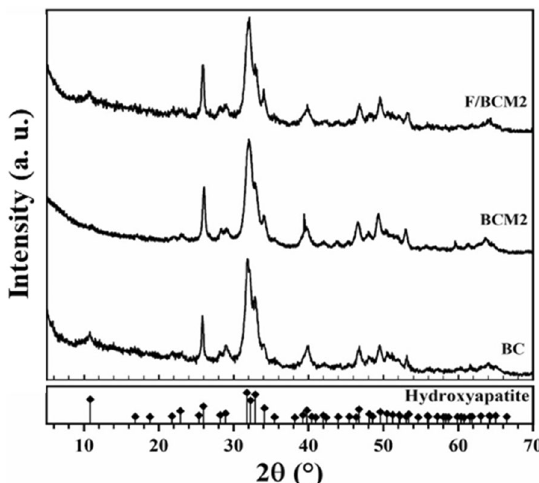
Fig. 1 XRD patterns of BC, BCM2, and F/BCM2. The standard of hydroxyapatite is at the bottom